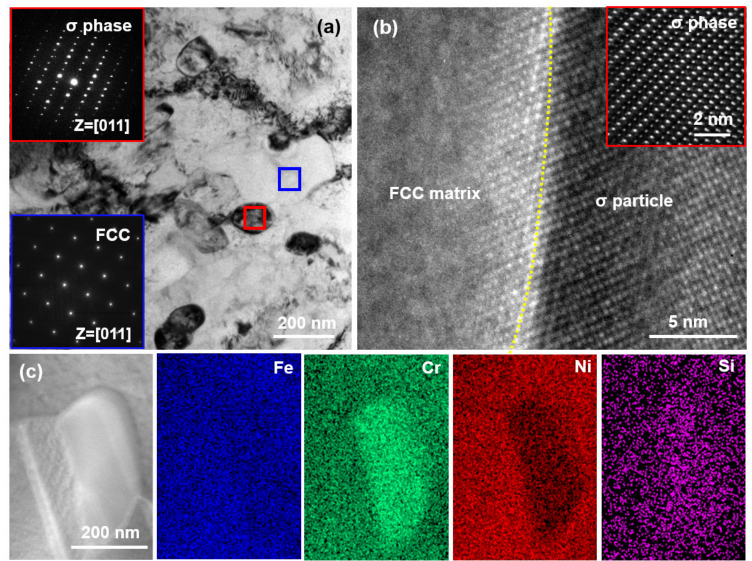
Figure 6. ( a ) BF image of the Si 0.15 -750 MEA. ( b ) HRTEM showing the phase interface between the FCC matrix and σ particle. ( c ) STEM EDS elemental distribution mapping showing the chemical composition of the σ